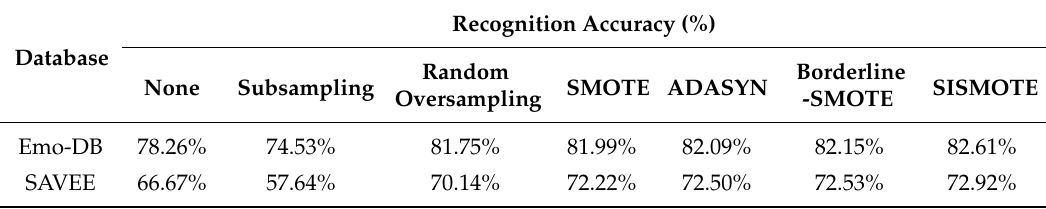
Table 3. Comparative results using different imbalance processing methods on Emo-DB and SAVEE.